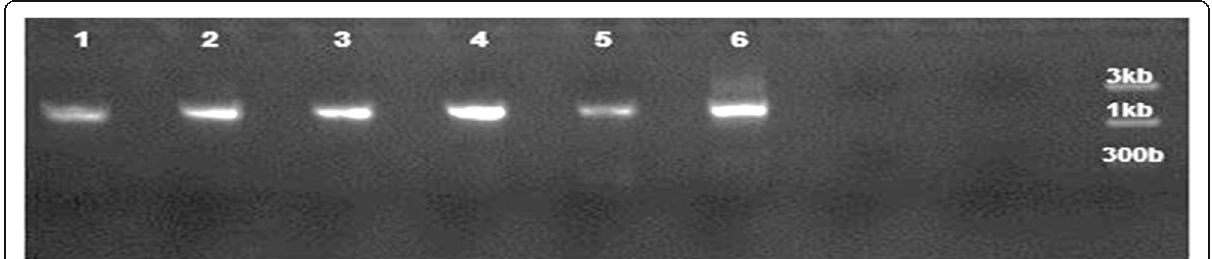
Fig. 1 Gel electrophoresis of 2% agarose gel illustrating the amplification of partial 16S rRNA genes of isolates DL2 and DL6 (lanes 2 and 6,